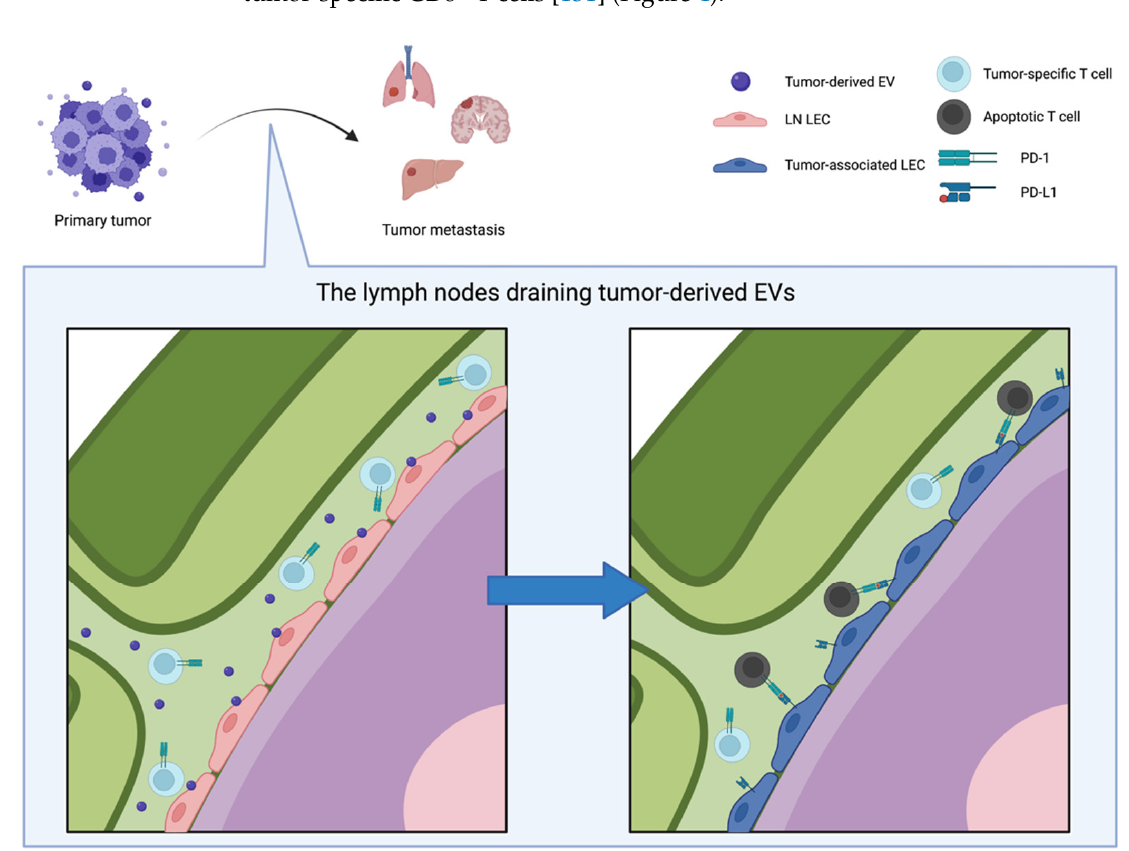
Figure 4. Tumor-derived EVs interact with lymph node resident lymphatic endothelial cells (LNLEC) and induce expression of PD-L1 on the surface of LNLEC. The tumor-associated LECs induce apoptosis of tumor-specific T cells by binding PD-1 on their surface, which results in tumor immune tolerance and tumor progression.